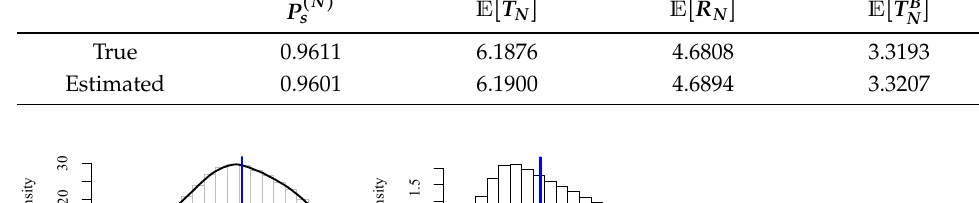
Table 2. Comparison of the true and estimated values for P ( N ) s , E [ T N ] , E [ R N ] and E [ T B